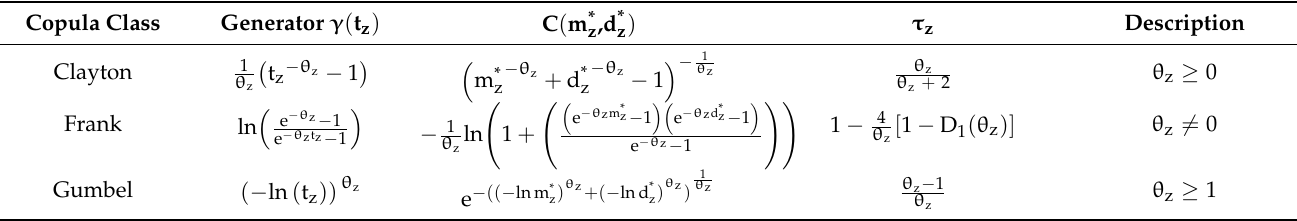
Table 2. Archimedean Copula